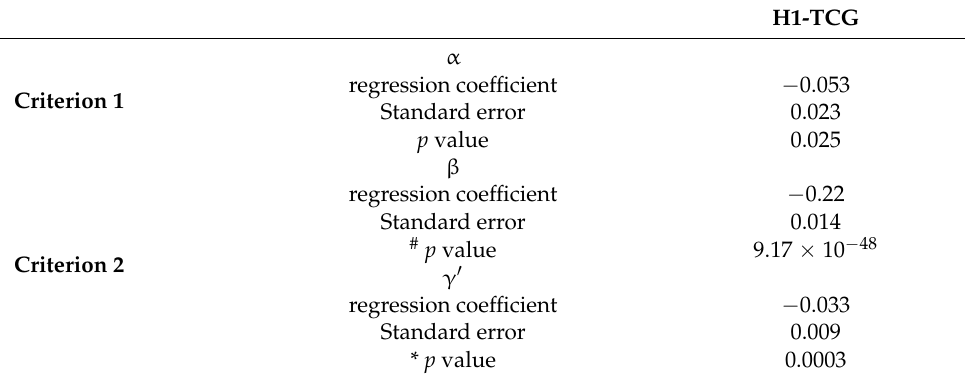
Table 3. Mediation tests of triglyceride (TG) levels for the association between LIPC haplotype and HDL-C